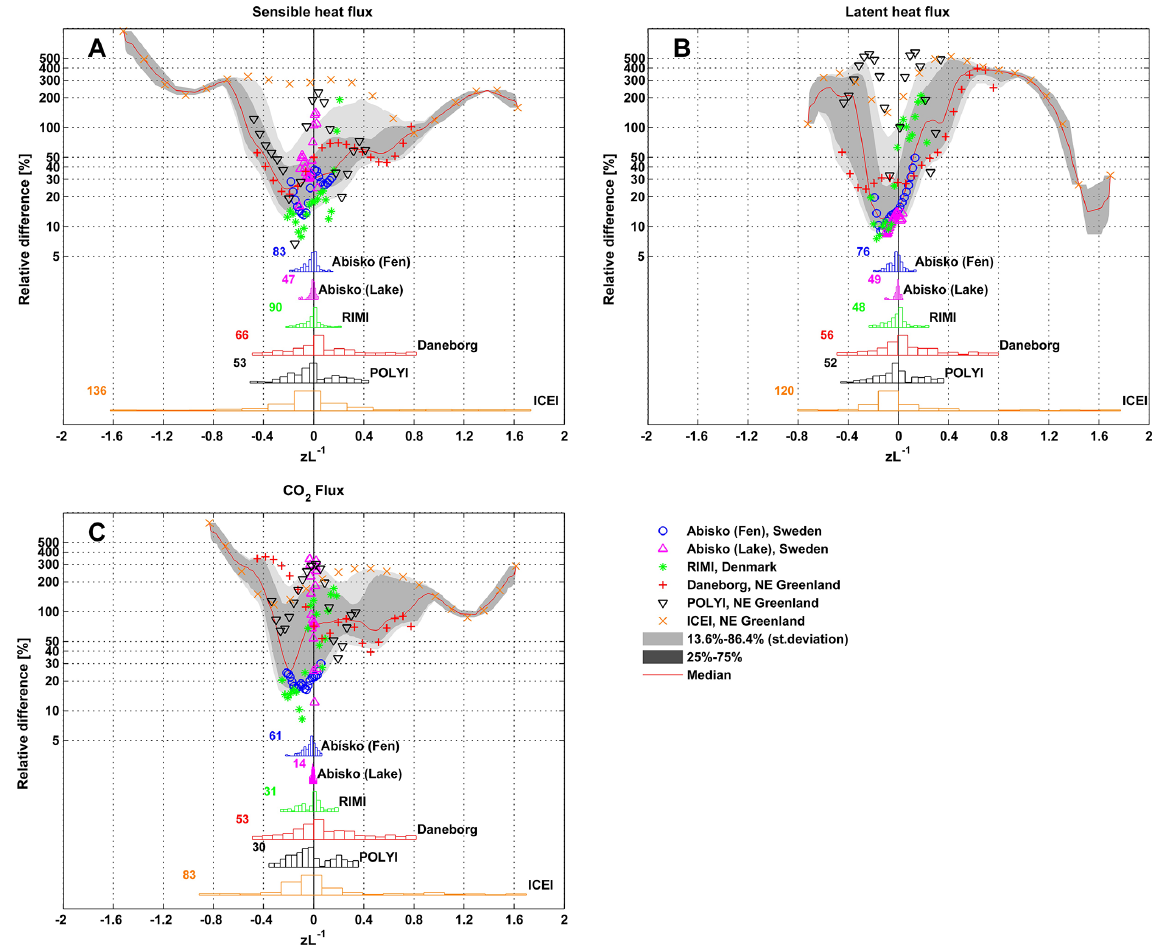
Figure 12. As Fig. 11, but here the relative difference is shown as a function of atmospheric stability zL − 1 for all investigated